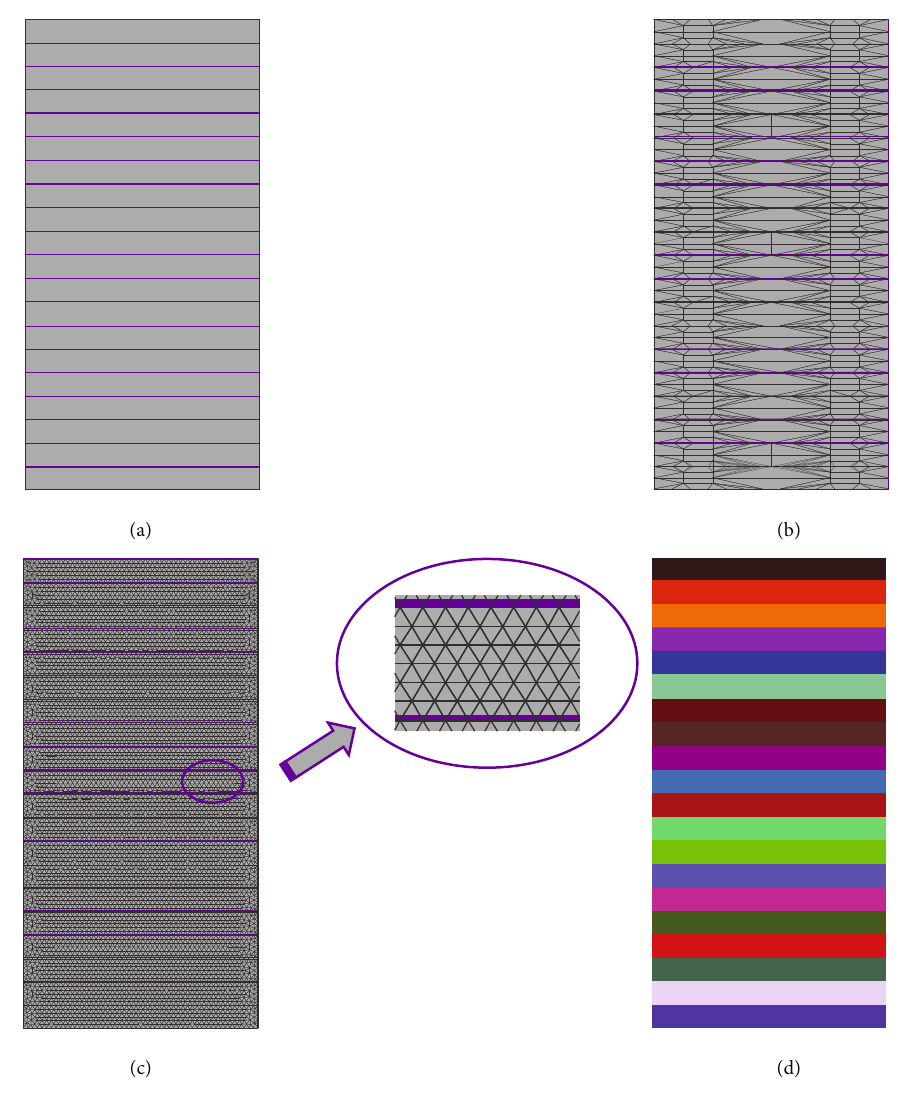
Figure 5: Rock model and rigid block generation